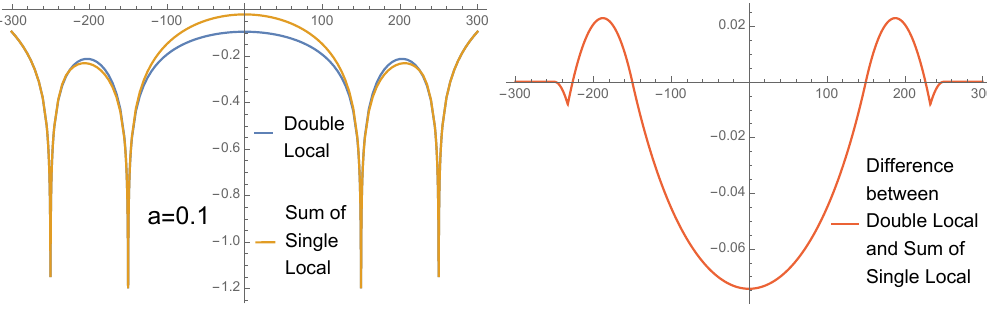
Figure 20 . The plot of the full HEE (cid:1) S D for the double joining local quench and the di(cid:11)erence A (cid:1) S D (cid:1) S S ( x = b ) (cid:1) S S ( x = (cid:0) b ) between the double and single quench at t = 0 as a function of x . A (cid:0) (cid:0)